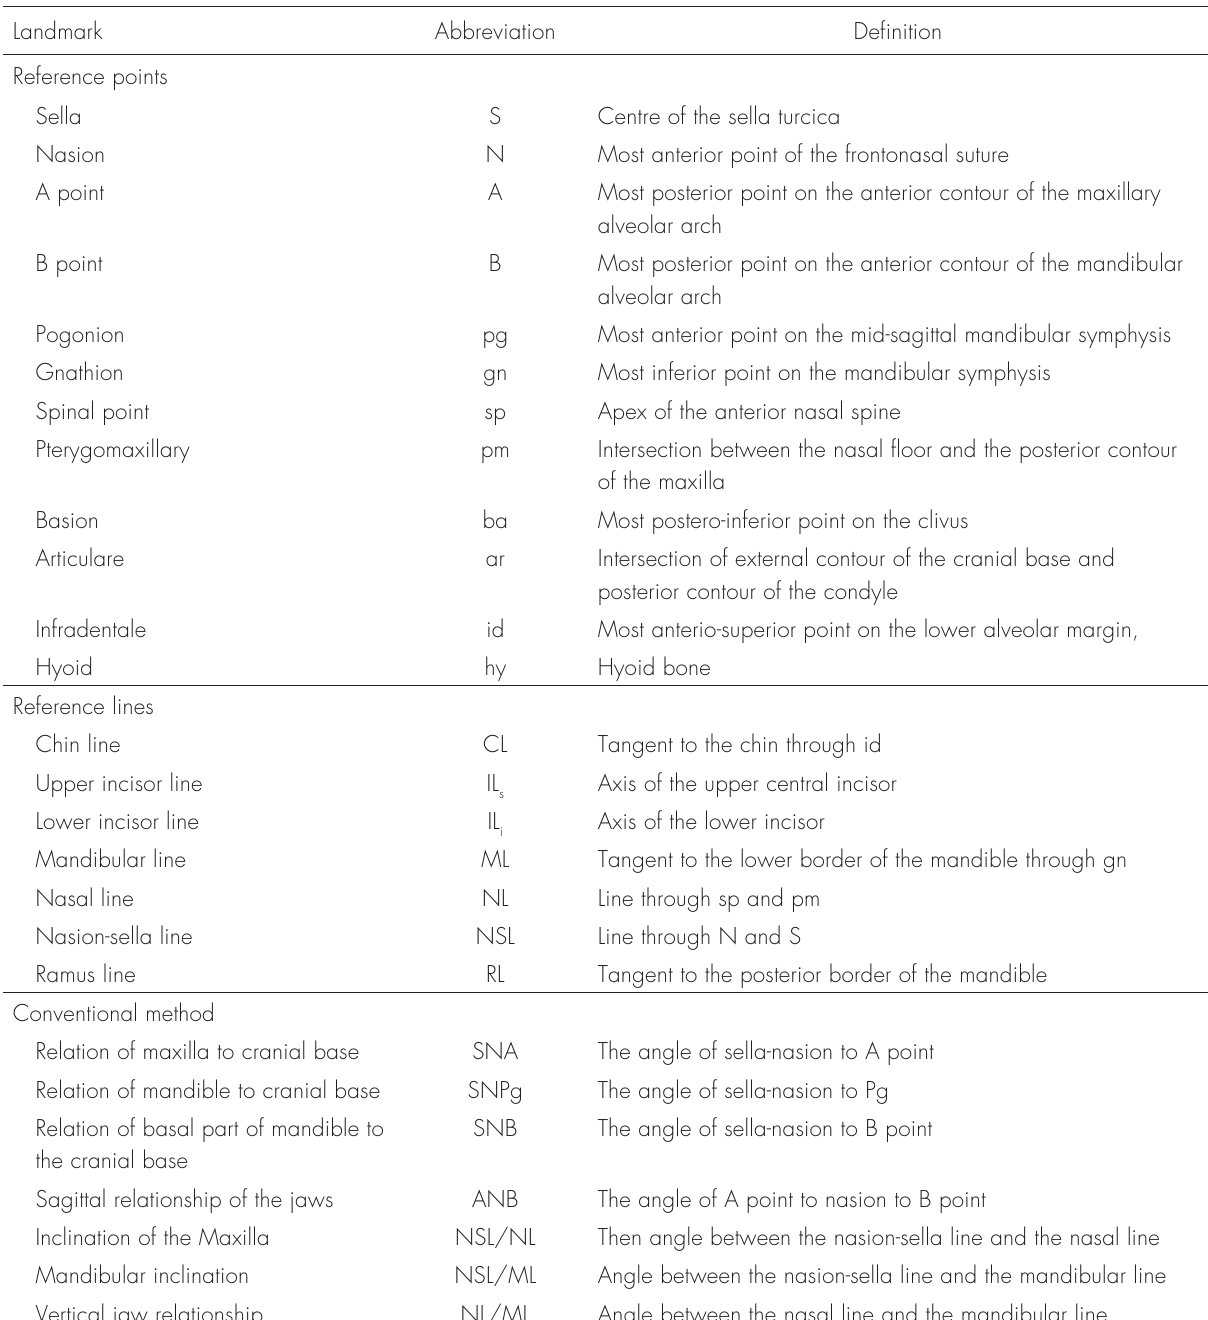
Table III. Cephalometric landmarks 19 used to assess FA changes using both the structural and conventional methods (illustrated in Figure 1).